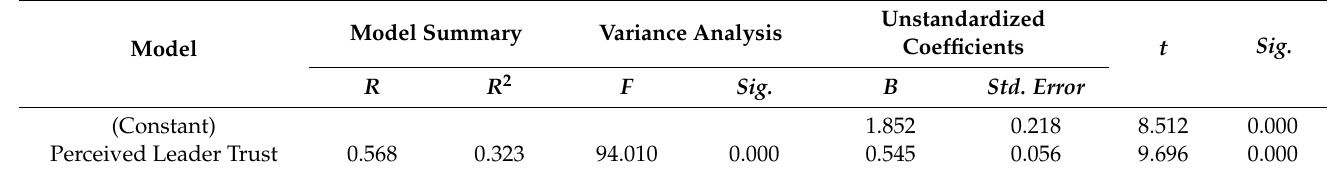
Table 18. Regression Analysis of Perceived Leader Trust on Psychological Empowerment.